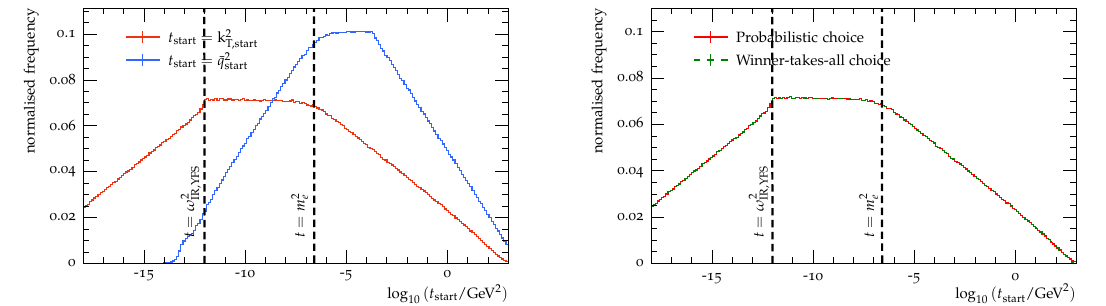
Figure 1 . Left: a comparison of the frequency of the reconstructed starting scales t start using two choices for the evolution variable t , k 2 or ¯ q 2 , in the reconstructed initial e ± T a comparison of the frequency of the reconstructed starting scales t start = k 2 probabilistic determination of the emitter lepton or a winner-takes-all in the reconstructed initial e ± e ± γ splitting. The threshold for photons splitting into charged particle pairs is t > 4 m 2 → is the infrared cutoff of the YFS-style algorithm which generates the photons. ω 2 IR , YFS